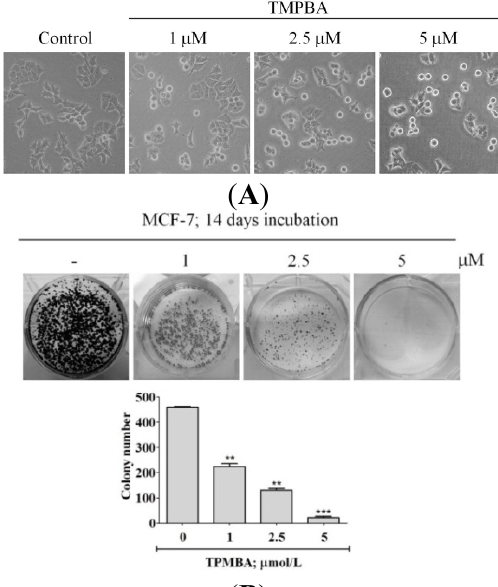
Figure 3. TMPBA changed cell morphology and decreased colony formation ability of MCF-7 cells. ( A ) The morphological changes after a 24-hour TMPBA treatment with MCF-7 cells. The cells were followed by photography under phase-contrast magnification (200×); ( B ) MCF-7 cells were treated with compounds, and colony formation was scored after 14 days. The number of colonies in the graphs was representative of three independent experiments (lower panel). Data represent the mean ± SD ( n = 3). Significant differences ( ** , p < 0.01, *** , p < 0.001) between the control and experimental group are marked with